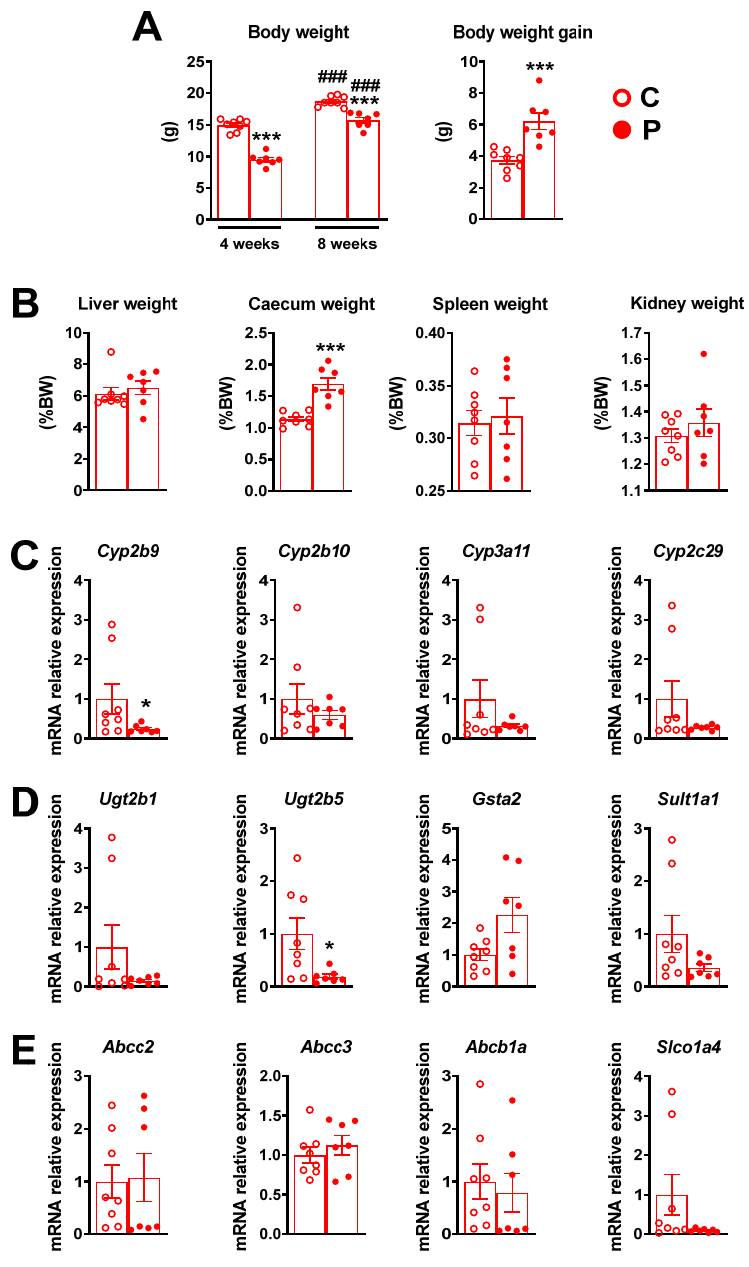
Figure 3. ( A ) Body weight in exposed and unexposed F1 female mice at 4 or 8 weeks of age. ( B ) Liver, caecum, spleen and kidney weight in 8-week-old exposed and unexposed F1 female mice. Hepatic mRNA relative expression of genes involved in phase I xenobiotic metabolism enzymes ( C ), phase II xenobiotic metabolism enzymes ( D ) and drug transporters ( E ) in F1 female mice upon dietary exposure to pesticides during gestation and lactation periods and 8 weeks post weaning. Gene expression was assayed by RT-qPCR in liver samples of seven exposed and eight unexposed F1 female mice. Data are presented as mean ± SEM. ###, *** p < 0.0005 for P vs. C, * p < 0.01 for P vs.